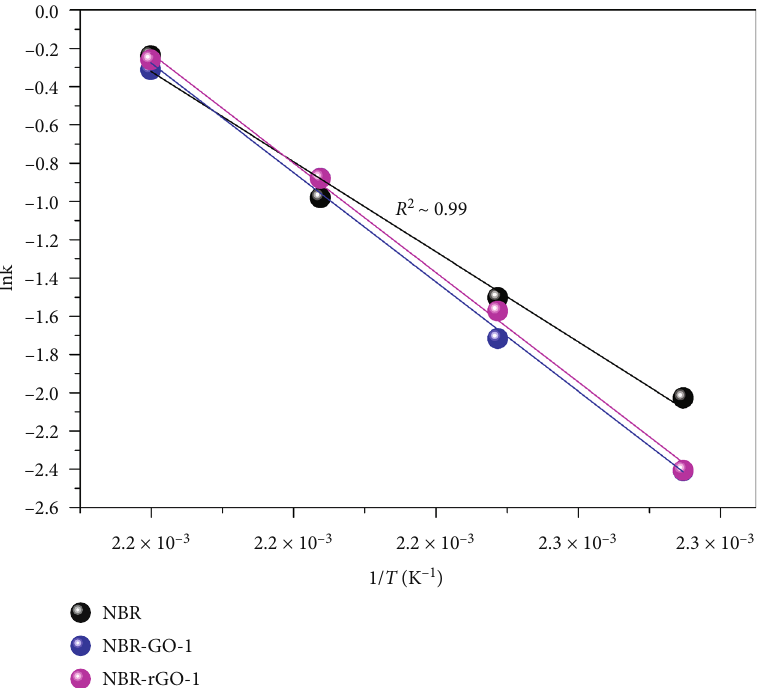
Figure 5: Arrhenius plot of ln k versus 1/ T for non-activated NBR, NBR – GO, and NBR – rGO